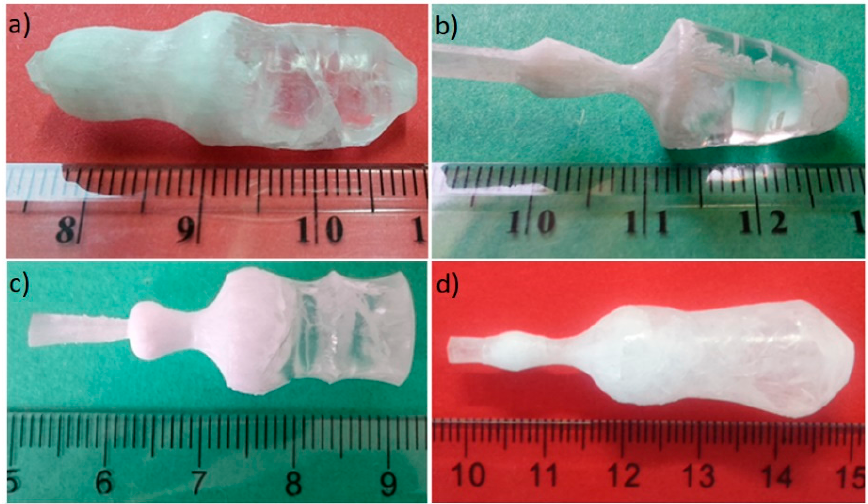
Figure 3. Thermal setup developed for growing LYSB-type crystals by the Czochralski crystal growth technique. (Reprinted with permission from ref. [13], copyright 2019 American Chemical Society).